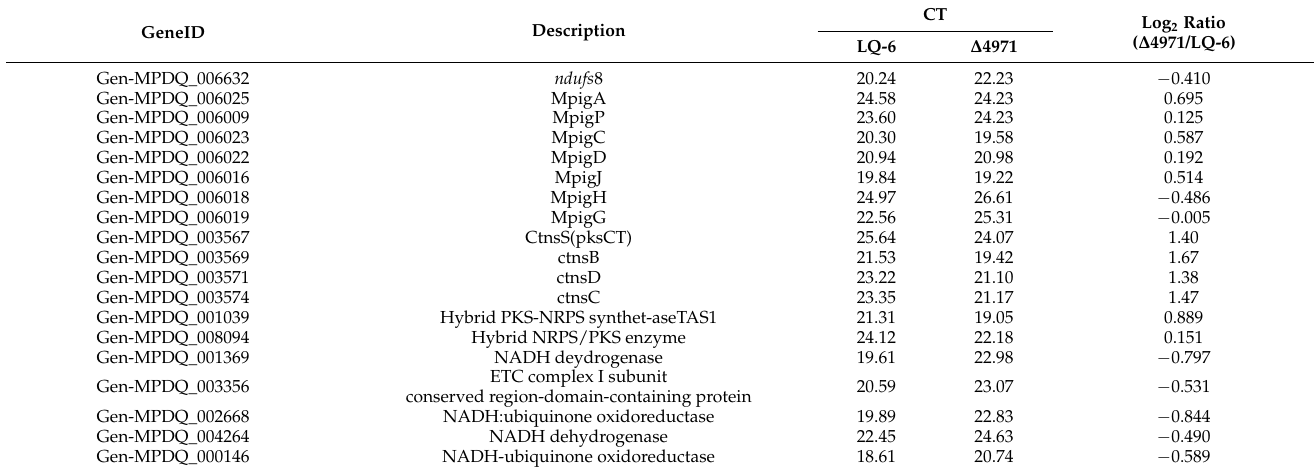
Figure 12. Comparison of gene expression in fatty acid synthesis pathway ( A ), fatty acid degradation pathway ( B ), polyketone synthesis ( C ), citrinin biosynthesis gene cluster ( D ), monascus pigments biosynthesis gene cluster ( E ) between the mutant strain M. purpureus ∆ 4971 (MT) and the wild-type strain M. purpureus LQ-6 (WT). Table 3. The validation of transcriptome data by RT-qPCR.